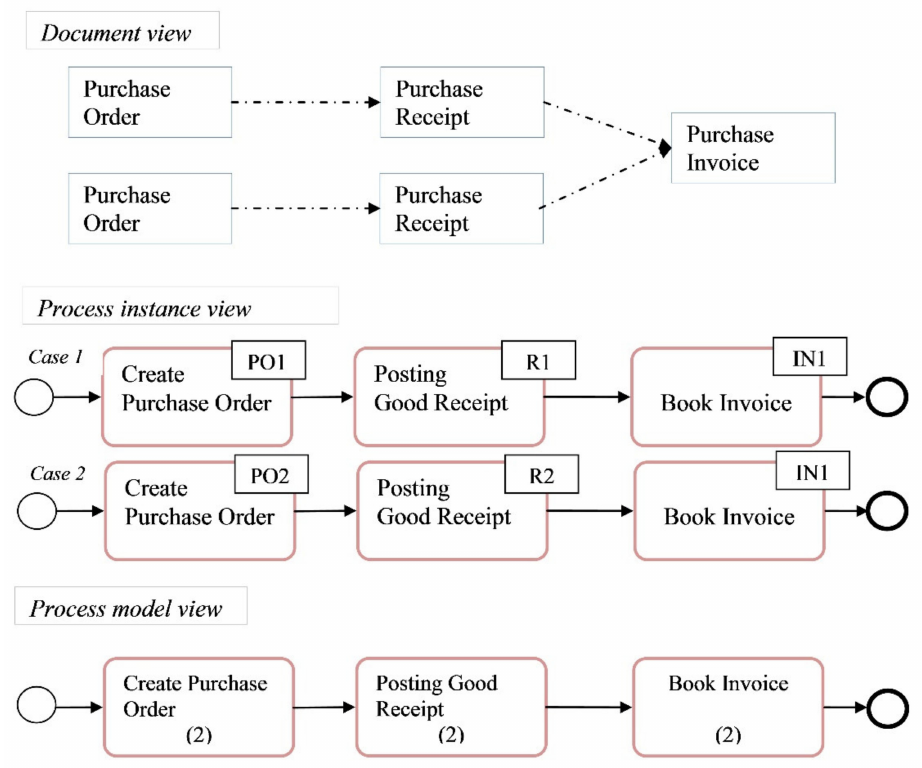
Figure 3. Data convergence problem as visualized from different